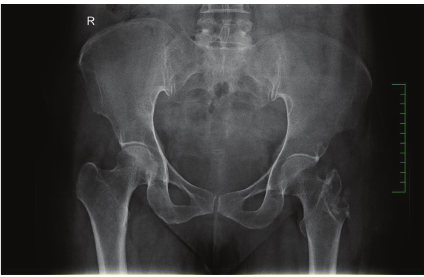
Figure 2: X-ray of the pelvis with both hips showing a well-defined eccentric osteolytic lesion involving the left greater trochanter with an enlarged soft tissue shadow adjacent to